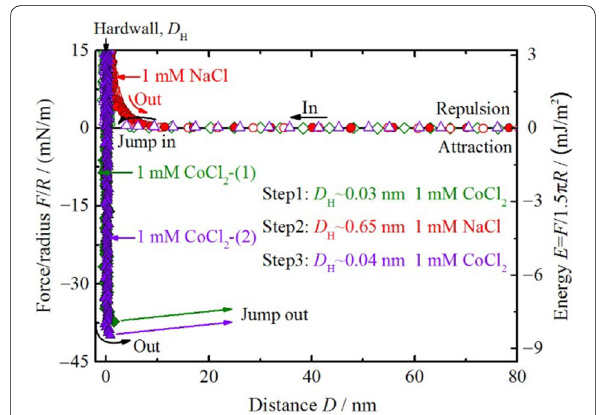
Figure 5 Force‑distance profiles between two bare mica surfaces in certain buffer